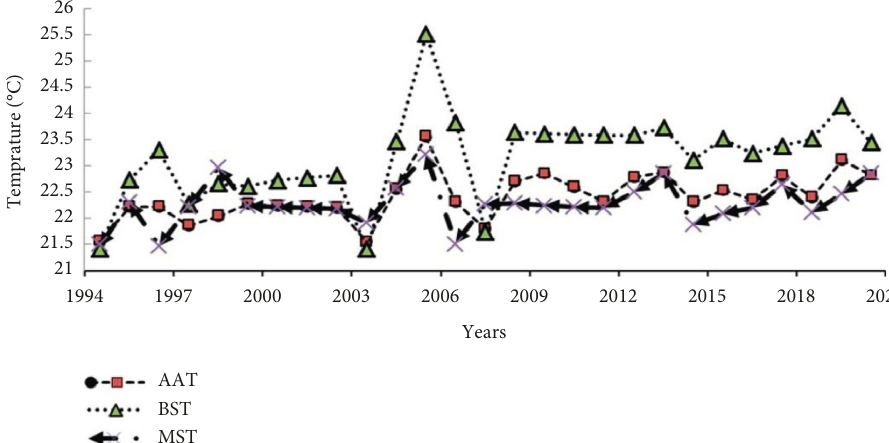
Figure 2: Average annual Belg (spring) and Meher (summer) seasonal temperature. Source: data from meteorological station data result (2021). Note: AAT: average annual temperature, BST: “Belg (spring)” seasonal temperature, and MST “Meher (summer)” seasonal